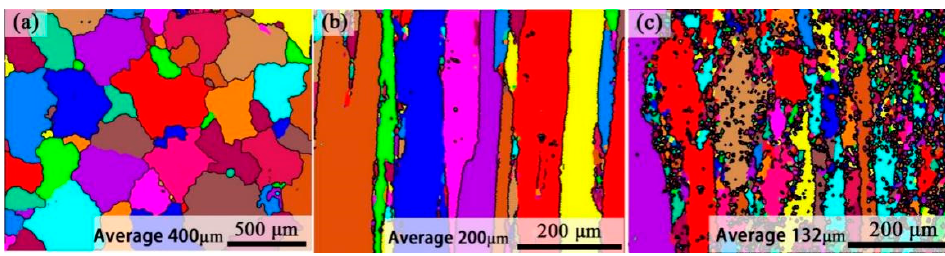
Figure 4. EBSD diagram of alloy microstructure. ( a ) original grain structure. ( b ) pre-deformed structure. ( c ) cup-shaped structure after annual channel angular